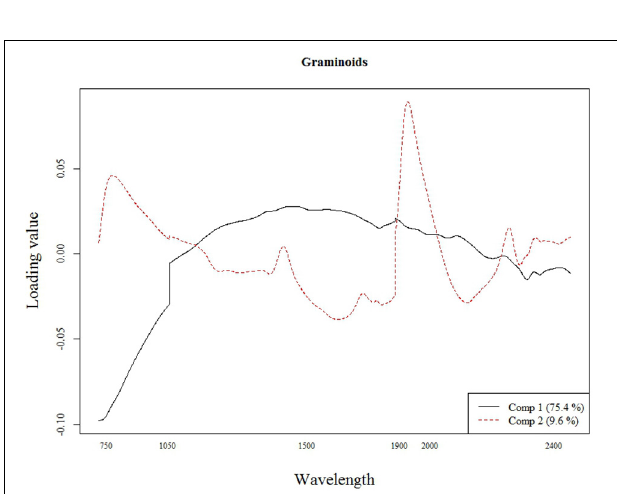
FIGURE 4 | Loading plot for the most important components of the calibration model for Deschampsia cespitosa